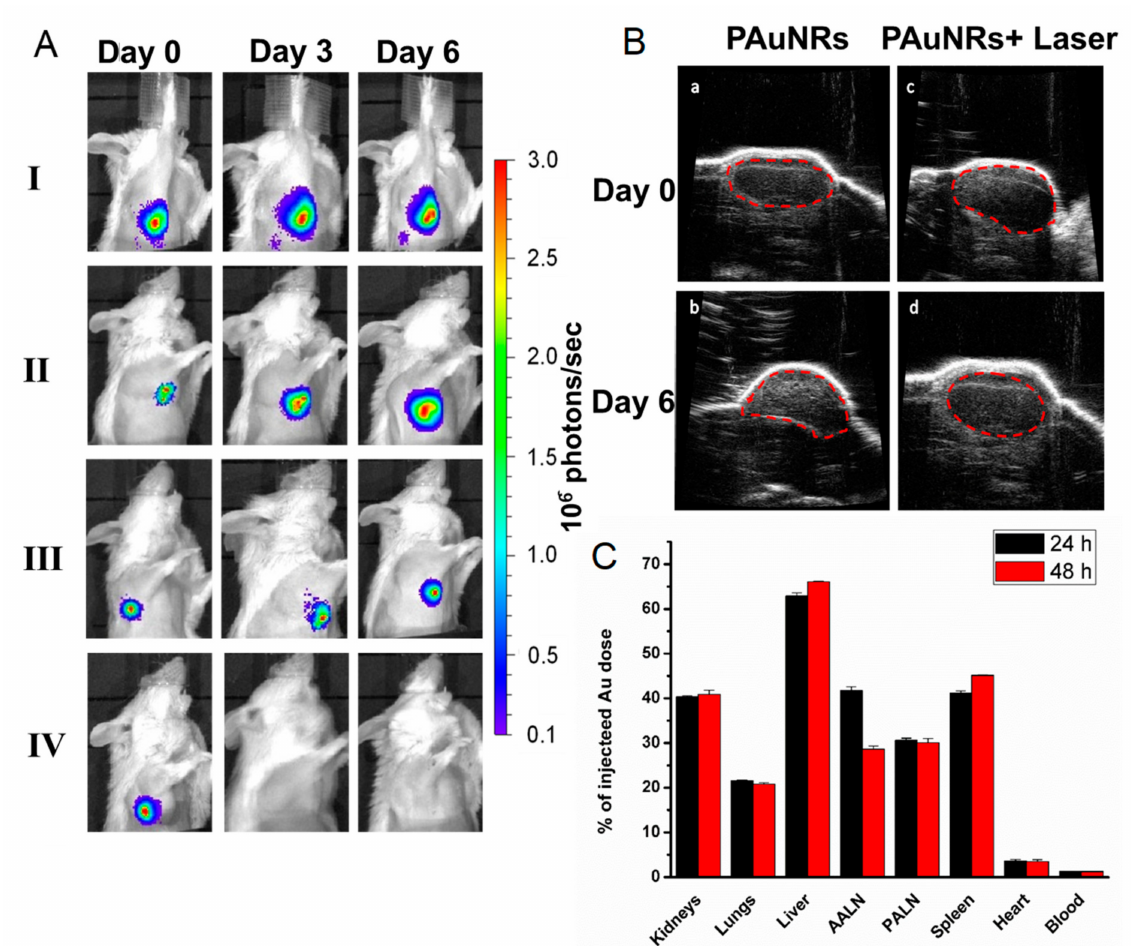
Figure 3. Anti-tumour evaluation of the treatment. ( A ) Representative images of tumour activities in the PALN of mice detected using an in vivo bioluminescence imaging system (IVIS) from day 0 to day 6 after treatment ( n = 6). ( B ) Temporal changes in the lymph node size of PAuNRs and PAuNRs + laser groups using two-dimensional (2D) high-frequency ultrasound images. Dashed lines indicate PALN regions. ( C ) Biodistribution of PAuNRs in the tissues measured as Au content using ICP-OES ( n =